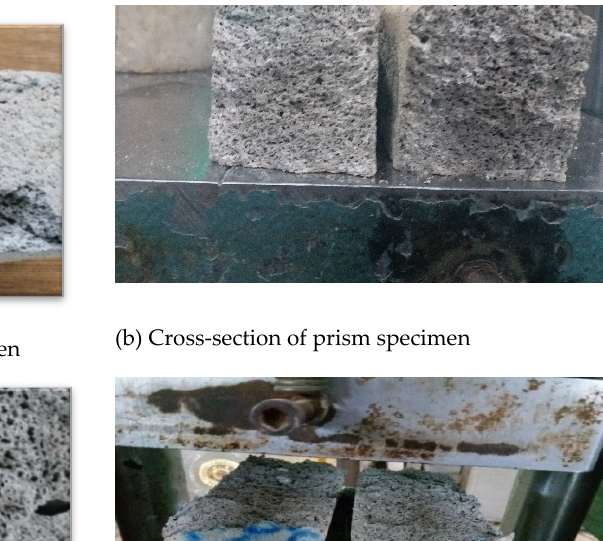
Figure 9. Flexural strength of aerated concrete.